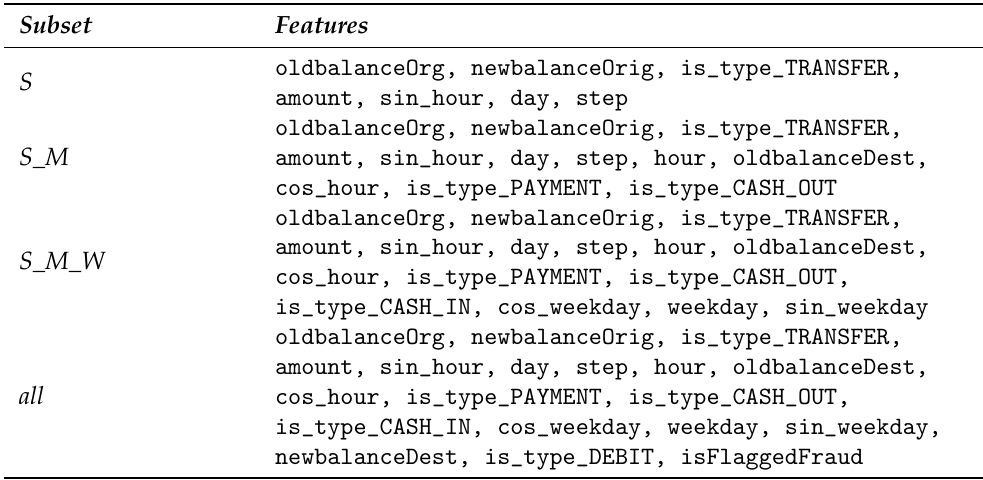
Table 15. PaySim fraud detection testing subsets.